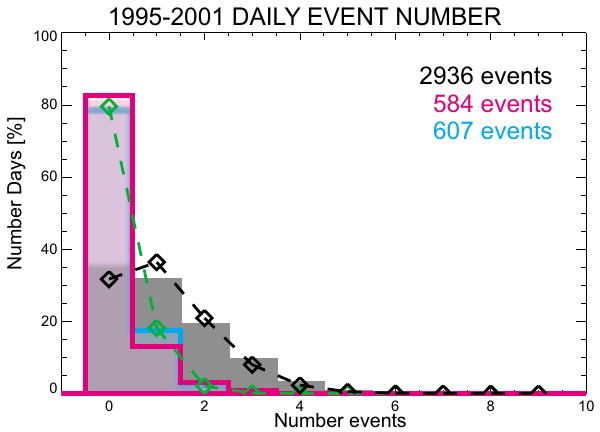
Fig. 8. Distributions of number of events per day are shown for all events (gray block diagram) as well as for the large and small am- plitude subgroups (magenta and cyan colors, respectively). Over- laid are the Poisson distributions for averages of 1.2 events per day (black line and diamonds) and 0.2 events per day (green line and diamonds).